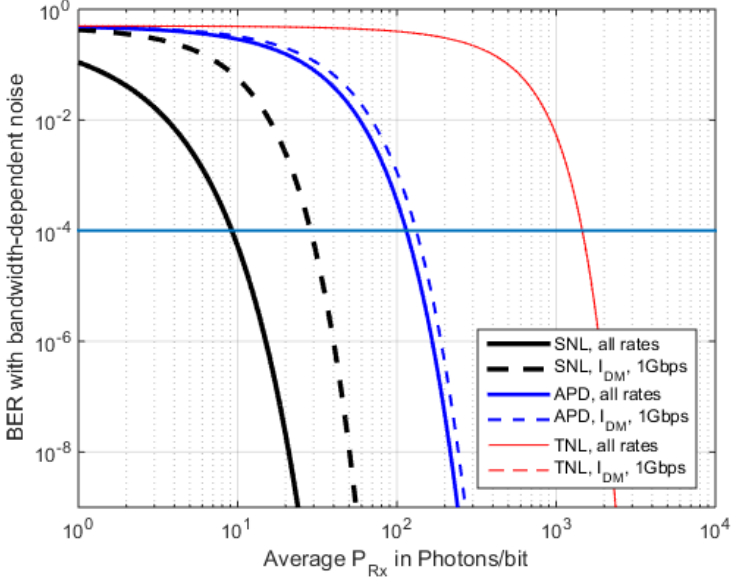
Figure 10. BER from Ppb for a sqrt( B )-dependent TIA noise density, according to the data rate, plus the adaptation of the reception filter bandwidth. Sensitivity curves with I dm are shown for comparison (for 1 Gbps, no BGL).